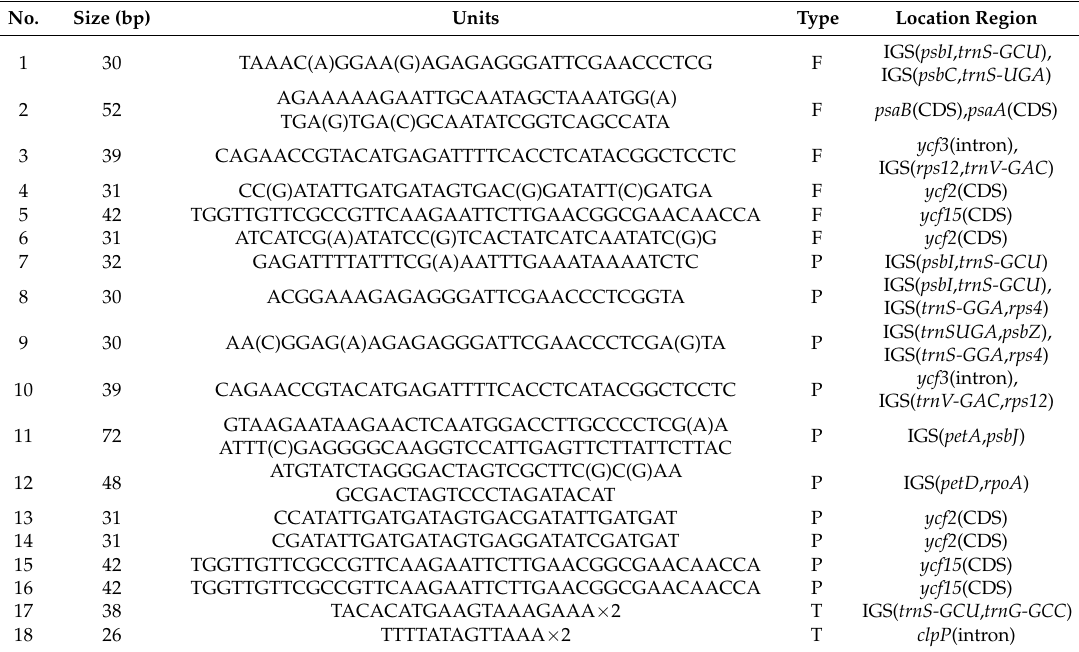
Table 3. The shared repeats of five Aconitum